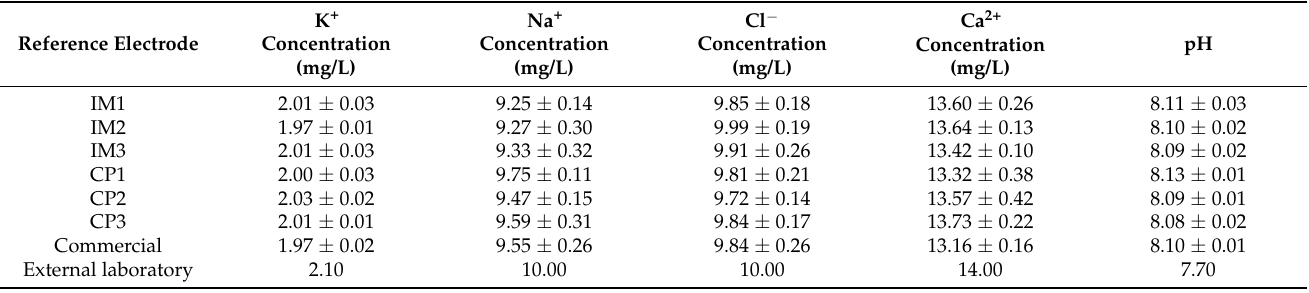
Table 6. Ion concentrations measured in RW2 at 5 ◦ C using SSC and commercial reference electrodes and compared with the results from routine laboratory analyses measured at room